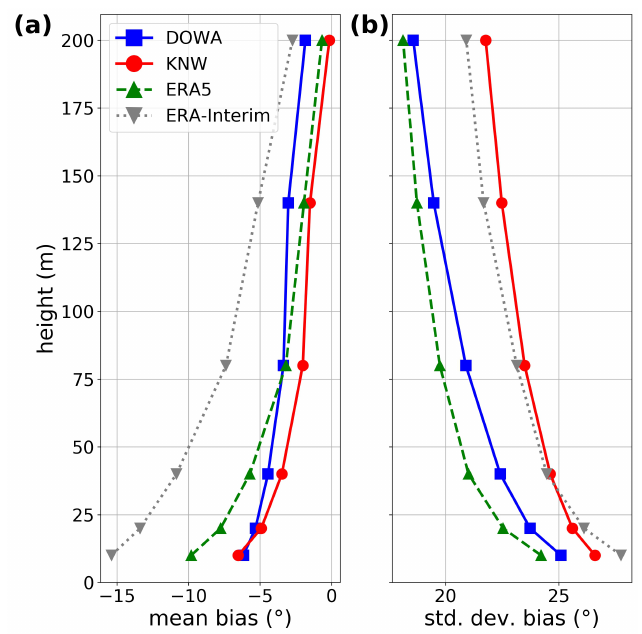
Figure 9. Height profile of ( a ) the mean bias (measurement minus model) and ( b ) standard deviation of the bias of the wind direction data: DOWA (blue), KNW atlas (red), ERA5 (green, dashed), and ERA-Interim (gray, dotted).